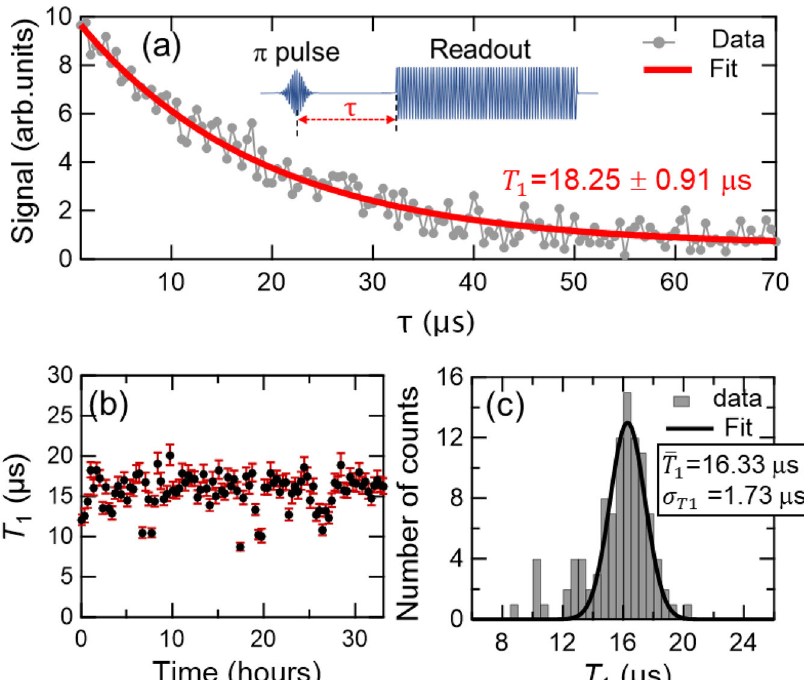
Fig. 3 Energy relaxation time T 1 and its temporal variation. a T 1 decay pro fi le with an exponential fi t (solid line) with T 1 ¼ 18 : 25 ± 0 : 91 μ s. The inset shows the pulse sequence for T 1 measurement consisting of a π pulse (having a Gaussian envelope) with a 40 ns duration at ω 01 and a readout pulse with a 400 ns duration at ω r . b Multiple T 1 values obtained from 100 measurements performed over 33 h, which show the temporal stability of T 1 . Here the error- bars correspond to the standard deviation calculated in the fi tting of each decay pro fi le. c Histogram of the T 1 values with a Gaussian fi t with center value (cid:1) T ¼ 16 : 3 μ s and standard deviation σ ¼ 1 : 73 μ s (Solid T 1 1